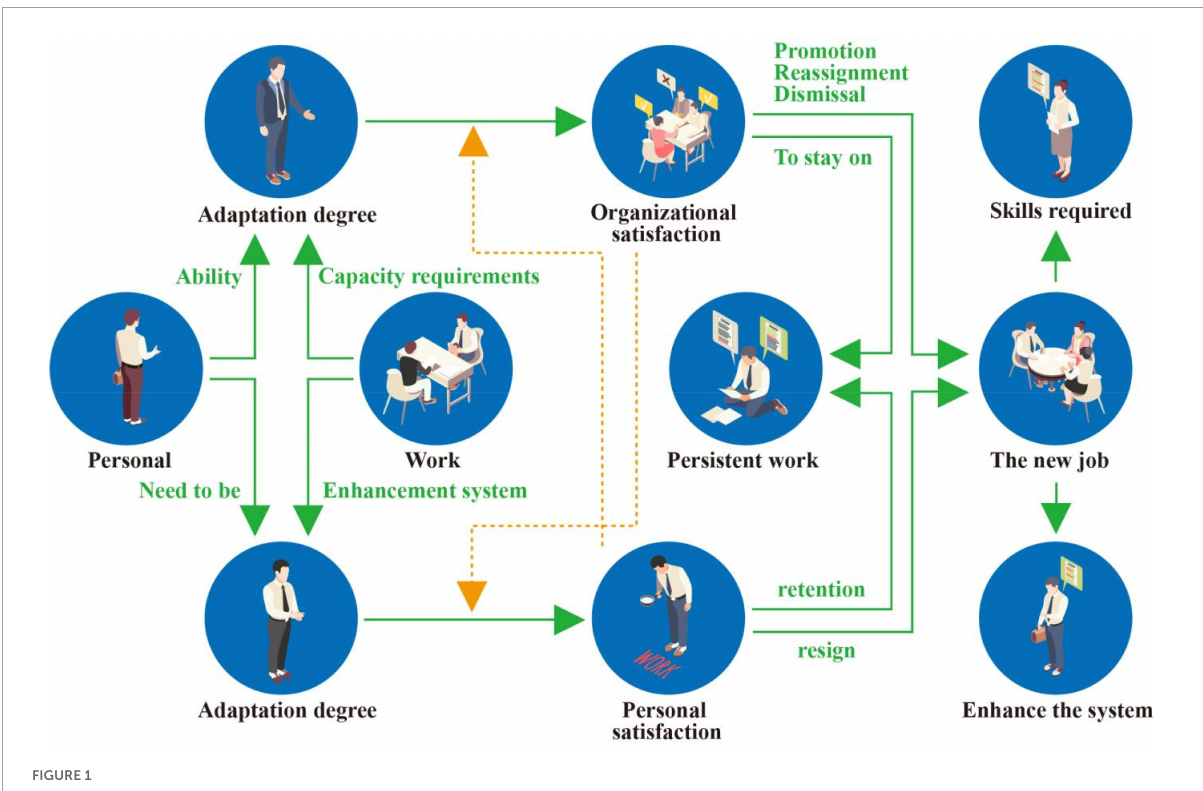
FIGURE1 Employment